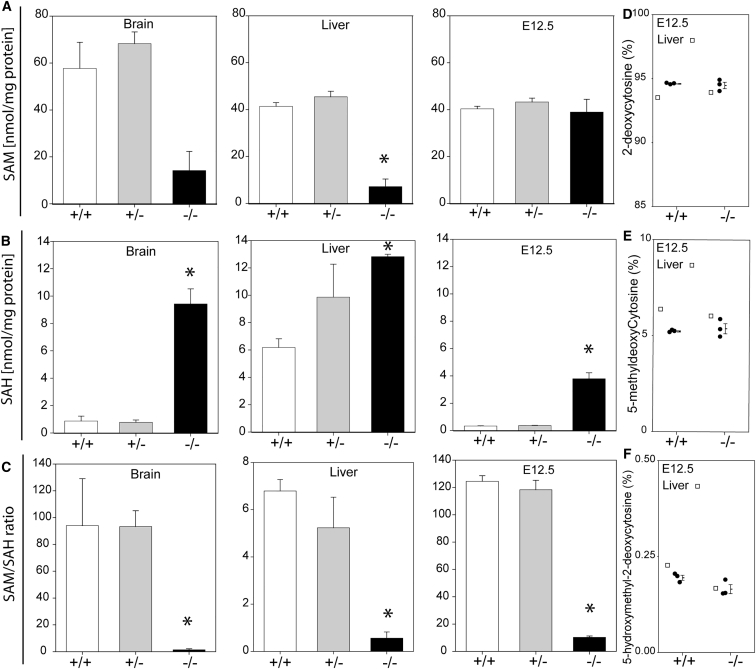
Methionine Cycle Intermediates Are Differentially Affected by Mthfr Genotype in Post-natal Tissue and Embryos(A) The abundance of S-adenosylmethionine (SAM) was significantly lower in livers of Mthfr−/− mice than in wild-types (∗p < 0.05), and SAM showed a non-significant trend toward lower abundance in brains of Mthfr−/− (p = 0.07). SAM abundance was not altered in Mthfr−/− E12.5 embryos compared with littermates of other genotypes.(B and C) In contrast, S-adensylhomocysteine concentration (B, SAH) was elevated, and the SAM/SAH ratio (C) was reduced in Mthfr−/− tissue and embryos compared with Mthfr+/+ (∗p < 0.01, significantly differs from Mthfr+/+). n = 3 samples per genotype for each tissue.(D–F) The proportion of (D) 2-deoxycytosine, (E) 5-methyldeoxycytosine, and (F) 5-hydroxy-2-deoxycytosine did not differ with Mthfr genotype among embryos at E12.5 (individual samples and mean ± SEM are shown).See also Table S2.